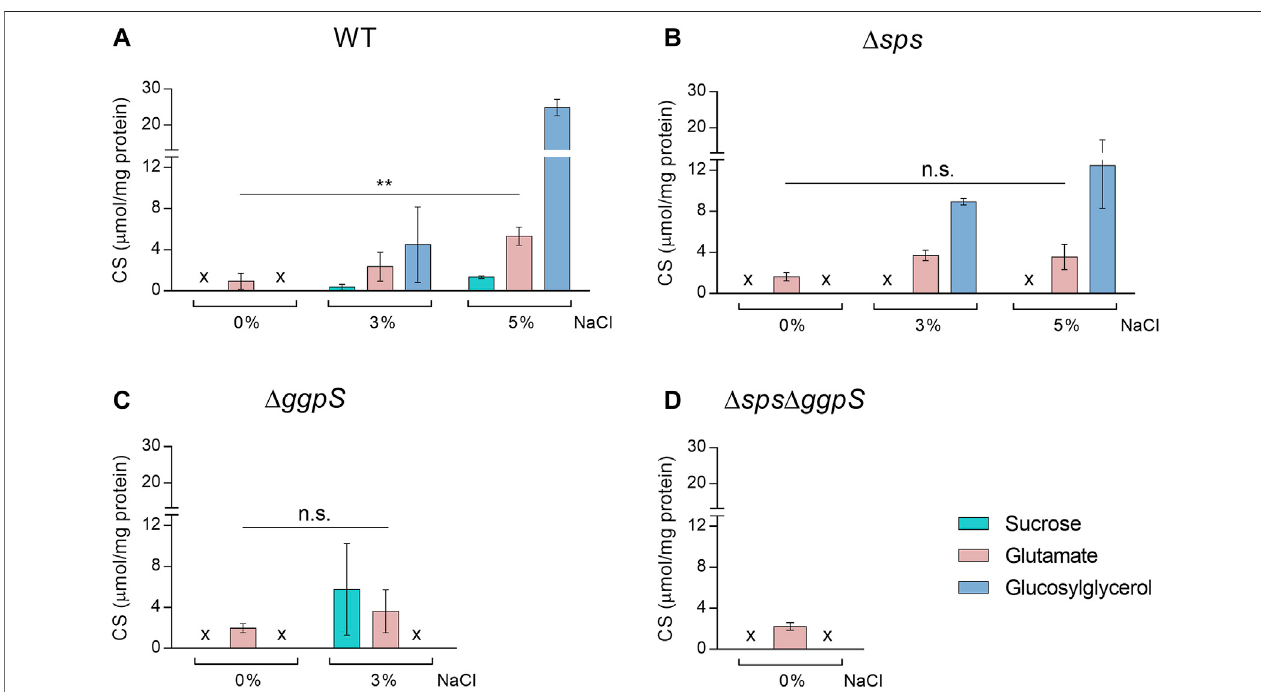
FIGURE2| EffectofNaClonthesynthesisofnativecompatiblesolutessucrose,glutamateandglucosylglycerolby Synechocystis wild-type(WT) (A) ,andthe Δ sps (B) , Δ ggpS (C), and Δ sps Δ ggpS mutants (D) .Culturesweregrown inBG11orBG11supplemented with3%or5%(wt/vol) NaCl, at 30 ° Cwithorbitalshaking(150 rpm) under a 12 h light (25 μ E/m 2 /s)/12 h dark regimen, and cells were harvested 4 days after inoculation (initial OD 730 ≈ 0.5). Compatible solutes were quanti fi ed by H-NMR andtheresultswerenormalizedpermgofprotein.x — notdetected.Errorbarscorrespondtostandarddeviationsfromatleastthreebiologicalreplicates.Statistical analysis was performed using two-way ANOVA. Statistically signi fi cant differences are identi fi ed: ** ( p ≤ 0.01) and n.s. (not signi fi cant).